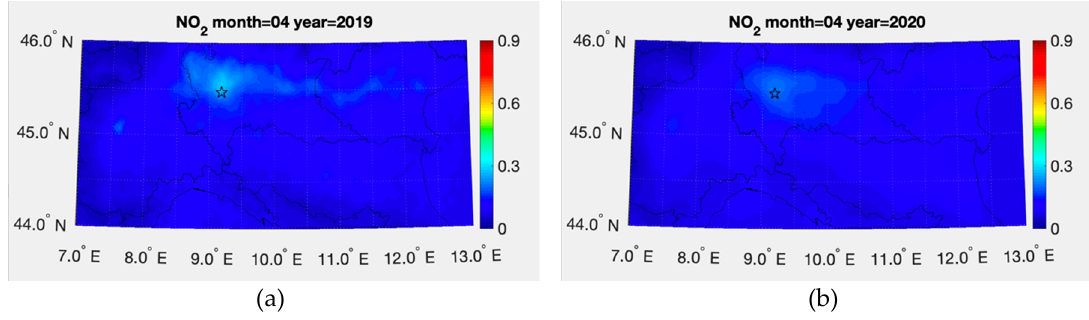
Figure 19. Monthly NO 2 pollution as revealed by TROPOMI for April 2019 ( a ) and April 2020 ( b ).